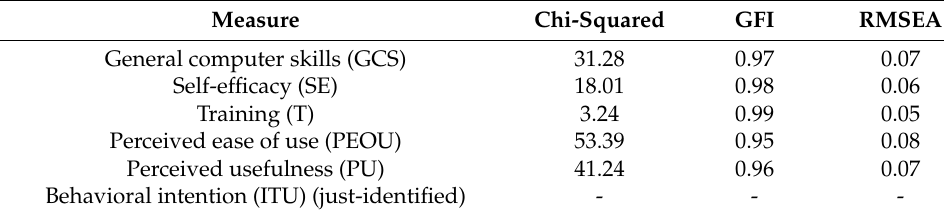
Table 4. Goodness of fit